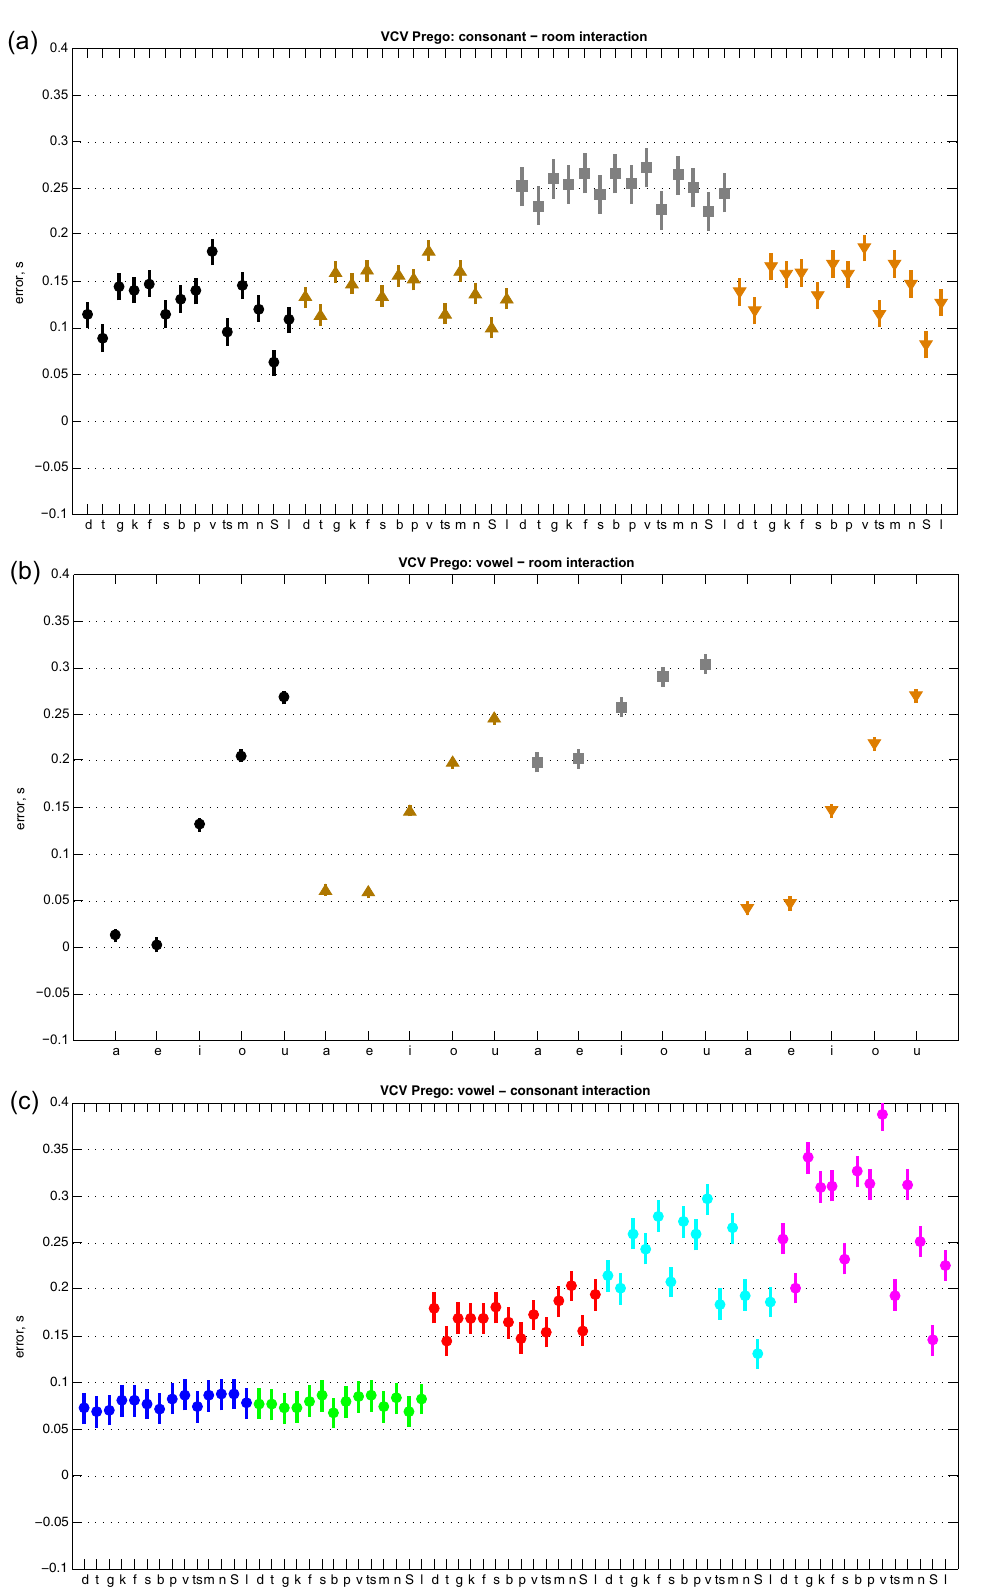
Figure 5. VCV logatomes: marginal means for Prego ’ s algorithm. (a) “ Consonant ” (cid:5) “ room ” interaction, (b) “ vowel ” (cid:5) “ room ” interaction, (c) “ vowel ” (cid:5) “ consonant ” interaction. For more details see Figure